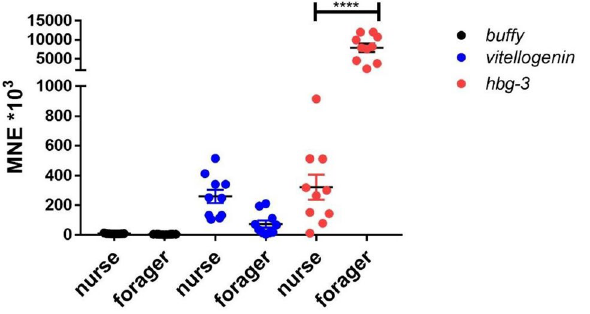
Figure 1. Abundance of transcripts of buffy (black symbols), vitellogenin (blue symbols) and hbg-3 (red symbols) in the brain of unexposed nurse bees (n = 10) and foragers (n = 10) from the same hive. Significant differences between nurse bees and foragers with p-value of ≤ 0.05 are marked with *.